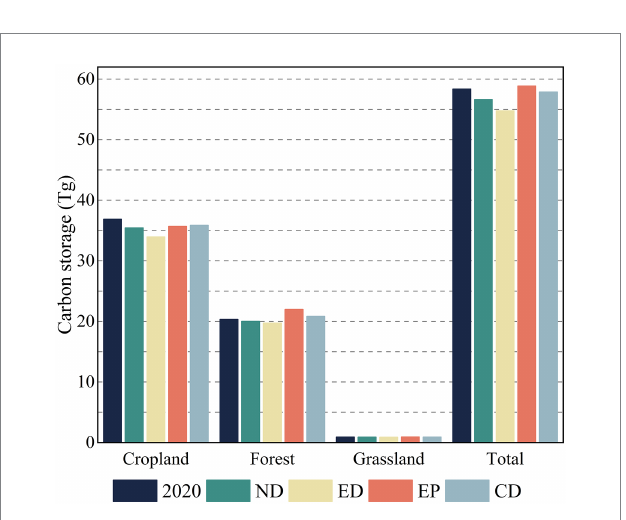
FIGURE 8 Carbon storage distribution in 2030 under four scenarios: (A) ND; (B) ED; (C) EP; and (D) CD.